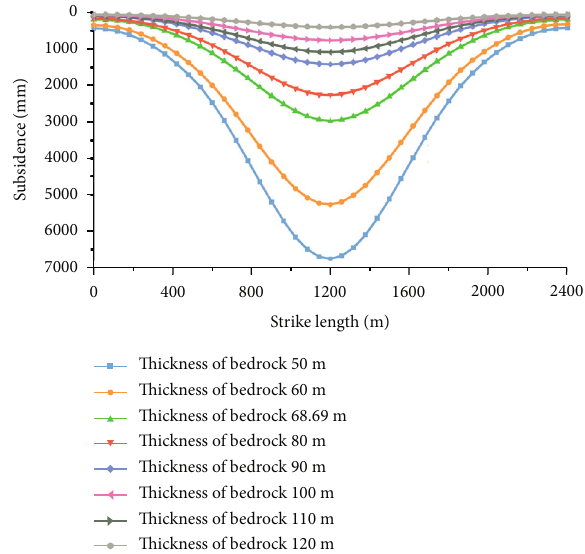
Figure 8: Surface subsidence curve in strike direction with di ff erent thickness of